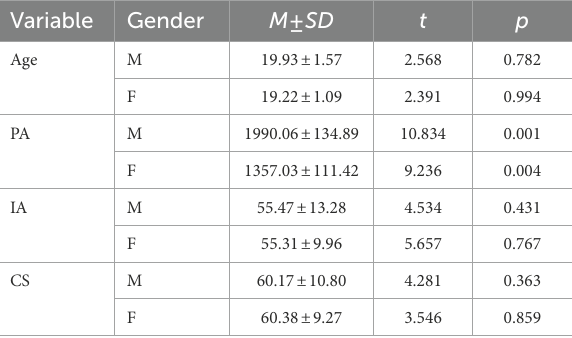
TABLE 2 Descriptive statistical analysis of age, PA, CS and IA.